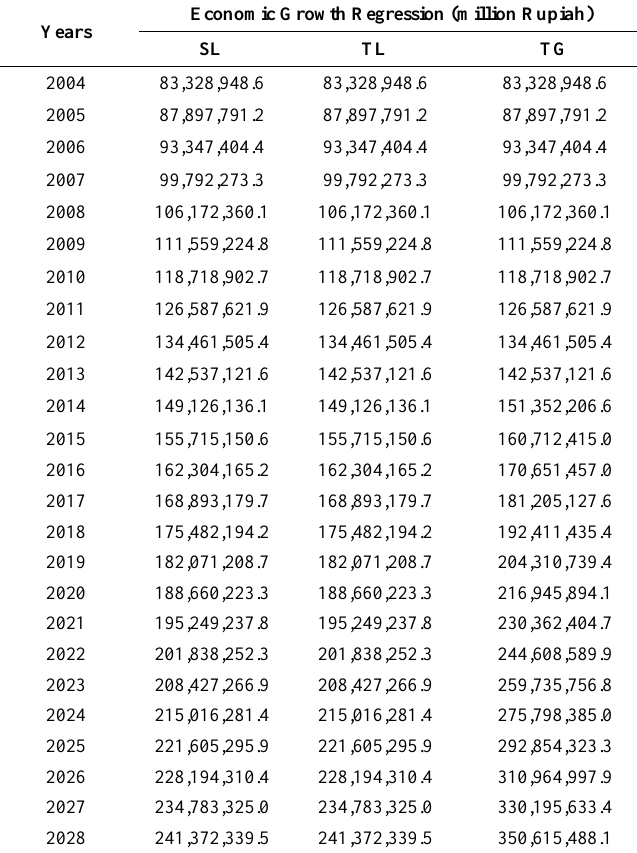
Table 4. Test results using Simple E